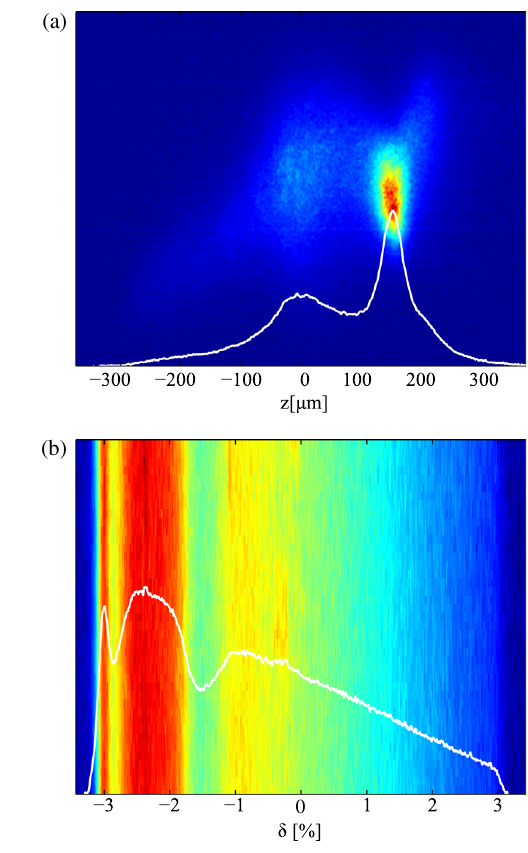
FIG. 2. Typical bunch profile measurement (a). Typical energy spectrum measurement (b). Color, from blue to red, indicates increasing detected intensity. The white curves are created by integrating the detected intensities vertically along the detectors, which gives a measure of longitudinal beam profile (a), and a measure of deviation from average energy